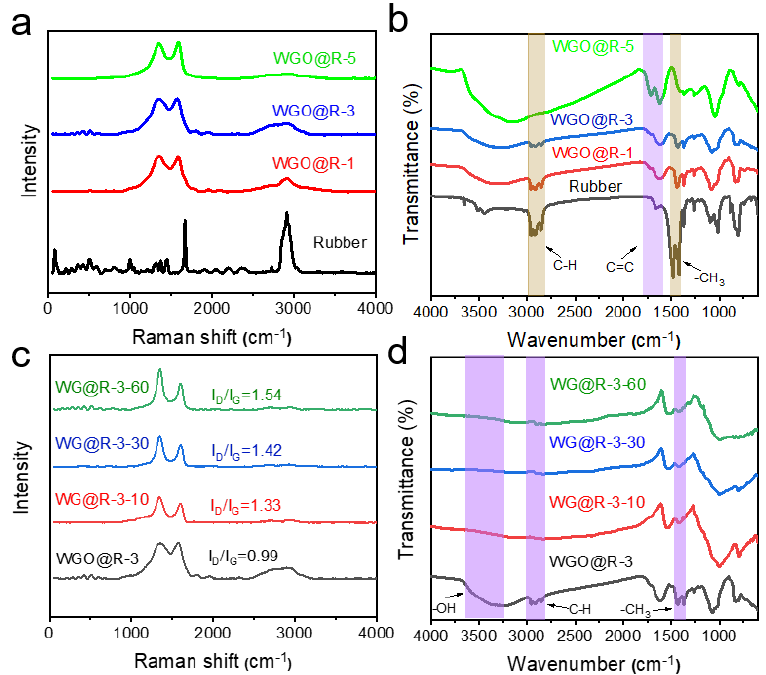
Figure 4. Chemical microstructures of WGO@R and WG@R. ( a ) Raman and ( b ) FT-IR spectra of rubber, WGO@R-1, WGO@R-2, and WGO@R-5; ( c ) Raman and ( d ) FT-IR spectra of WGO@R-2,